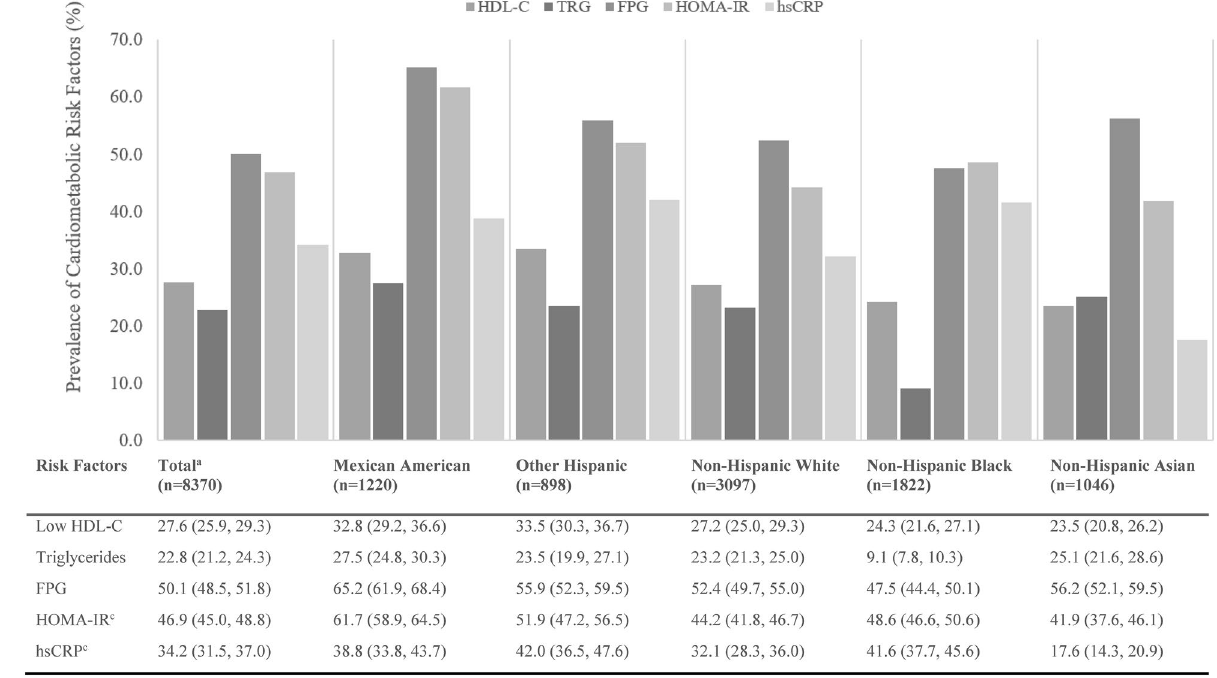
Figure 3. Age-standardized prevalence of cardiometabolic risk factor for adults ≥ 20 years by race/ethnicity. FPG fasting plasma glucose, HDL-C high density lipoprotein-cholesterol, HOMA-IR homeostatic model assessment of insulin resistance, hsCRP high-sensitivity C-reactive protein. Risk factors defined as, low HDL-C (< 40 mg/dL in men and < 50 mg/dL, in women), triglycerides (≥ 150 mg/dL), FPG (≥ 100 mg/dL and/or taking antidiabetic medication), HOMA-IR (≥ 2.5 [fasting glucose (mg/dL) × fasting insulin (mU/L)/405]), hsCRP (≥ 3 mg/L). Statistics are displayed as percent (95% confidential interval). a All values (except n) are weighted percentages, and age standardized to Census 2010 US